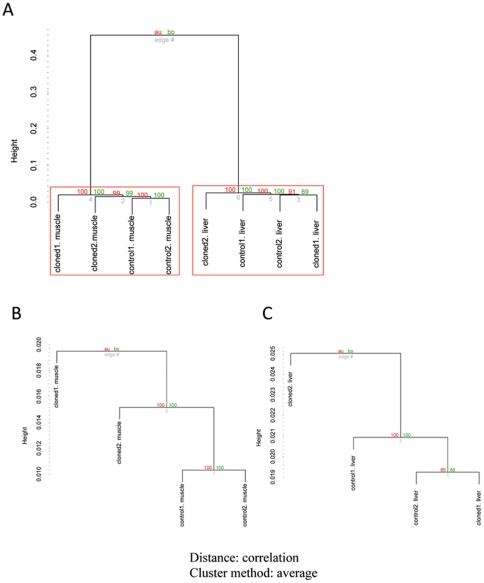
Hierarchical clustering of gene expression data from cloned and control pigs.The hierarchical clustering of gene expression data are shown for all 8 pig samples (A), only among the muscles (B), and only among the livers (C). P value of a cluster is a value between 0 and 1, indicating how strong the cluster is supported by data. Pvclust provides two types of P values (%) on the edge of the cluster: AU (Approximately Unbiased) P value and BP (Bootstrap Probability) P value. AU P values, shown in red, are computed by multiscale bootstrap re-sampling, and are better approximations to unbiased P values than the BP P value, shown in green, computed by normal bootstrap re-sampling. Clusters with AU P value larger than 95% are highlighted by rectangles and are strongly supported by data.